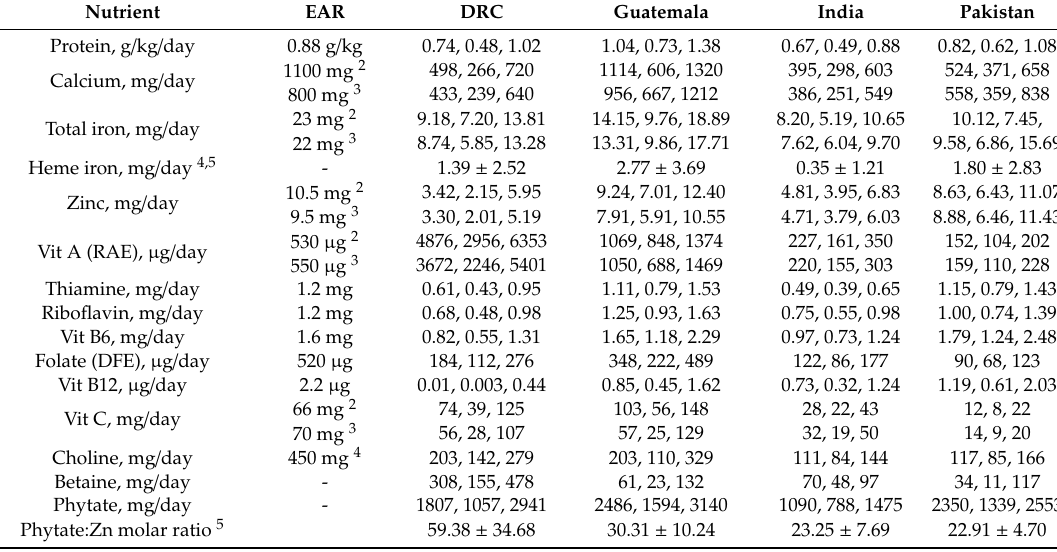
Table 3. Median, Q1, Q3 protein and micronutrient intakes 1 compared to the estimated average requirement (EAR) for pregnant women in four low- and middle-income